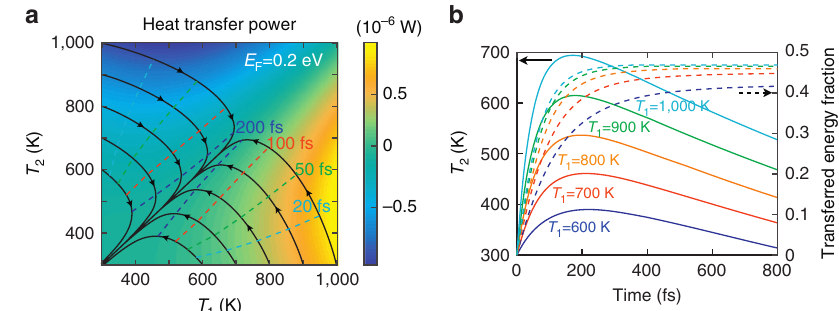
Fig. 3 Temperature and temporal dependences of radiative heat transfer. a HTP between two graphene nanodisks (20 nm diameter, 0.2 eV Fermi energy, d = 1 nm separation) as a function of T 1 and T 2 for the geometry of Fig. 1. Black solid curves represent the evolution of the electron temperatures in the two nanodisks for different initial conditions. Dashed curves indicate the times (see labels) along the evolution of the solid curves from either the vertical or the horizontal axes of the plot. We assume an inelastic relaxation time (electron-lattice coupling) of 1 ps. b Temporal evolution of the electron temperature T 2 in the colder disk (initially at T 2 = 300 K, left vertical scale , solid curves ) and the transferred energy fraction from disk 1 to disk 2 ( right vertical scale , dashed curves ) for different initial electron temperatures of the hotter disk T 1 (see labels)